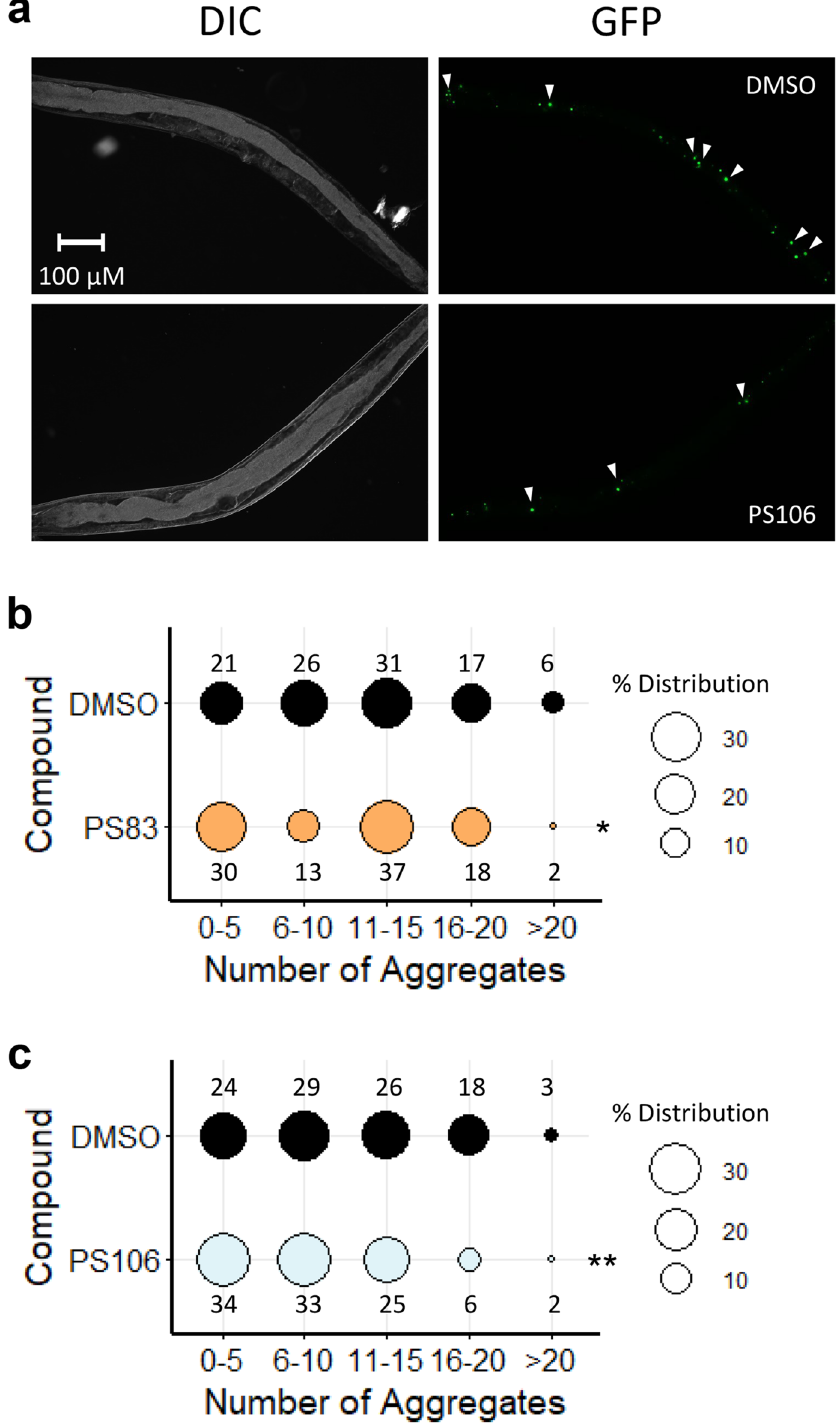
Figure 6. PS106 reduced aggregate formation in C. elegans strain expressing polyglutamine. ( a ) Representative DIC and GFP images of C. elegans strain expressing polyglutamine (Q82) (GF66) upon 36 h of treatment with DMSO or 25 µM PS106. ( b , c ) Percent distribution of the number of polyglutamine aggregates upon treatment with ( b ) 5 µM PS83 or ( c ) 25 µM PS106. Three biological replicates with ~ 30 worms/replicate were scored and analyzed. p -values were determined from Chi-square test. NS not significant, * p < 0.05, ** p <